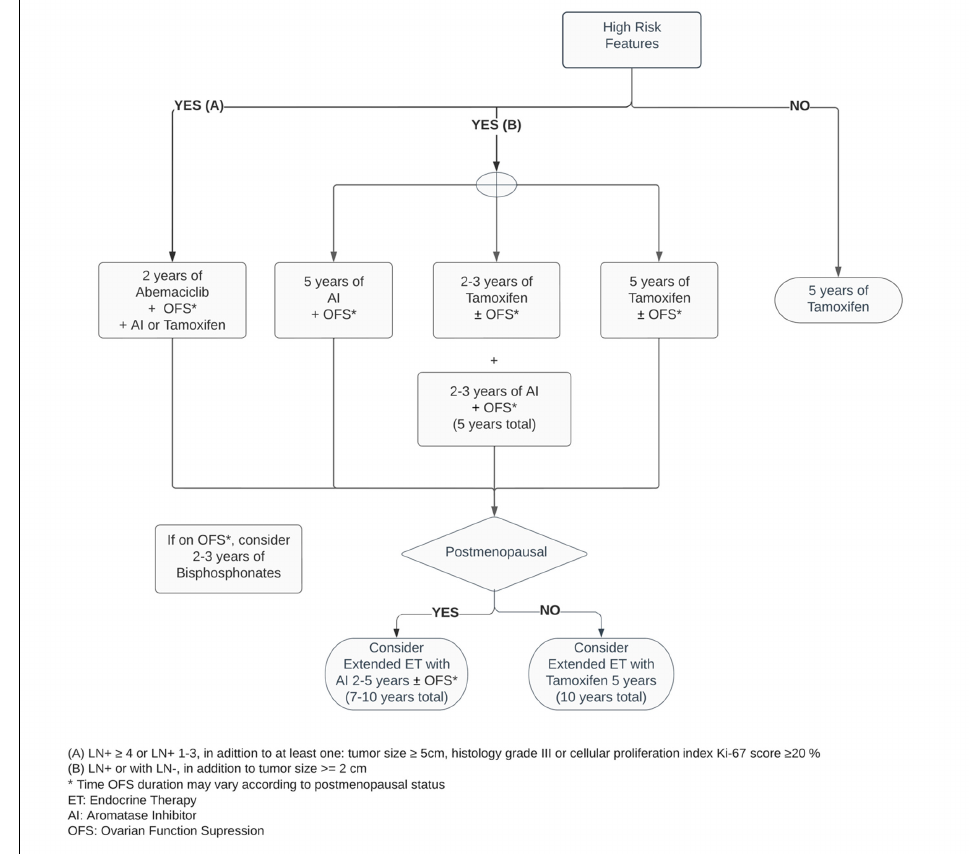
Figure 1. Adjuvant endocrine therapy for premenopausal women with ER+ HER2 − breast cancer. In postmenopausal women, the main source of estrogen comes from extragonadal tissues and is mediated by aromatase, a crucial enzyme responsible for a cascade of steroid synthesis and regulation. The AIs substantially reduce the circulating estrogen within plasma levels by suppressing its conversion from androgens, predominantly in adipose tissues. Hence, it leads to vasomotor symptoms such as hot flashes and vaginal dryness, as well as arthralgia, lipid metabolism dysregulation and bone mineral loss [37,40]. Five years of adjuvant treatment with AI in postmenopausal women has a similar efficacy and safety profile among Anastrozole, Letrozole and Exemestane [41–43]. When compared with Tamoxifen, the AIs have shown to be superior in postmenopausal pa- tients, reducing the risk of mortality by approximately 15% and distant and local recur- rence by 14% and 26%, respectively, at ten years (Figure 2) [44].